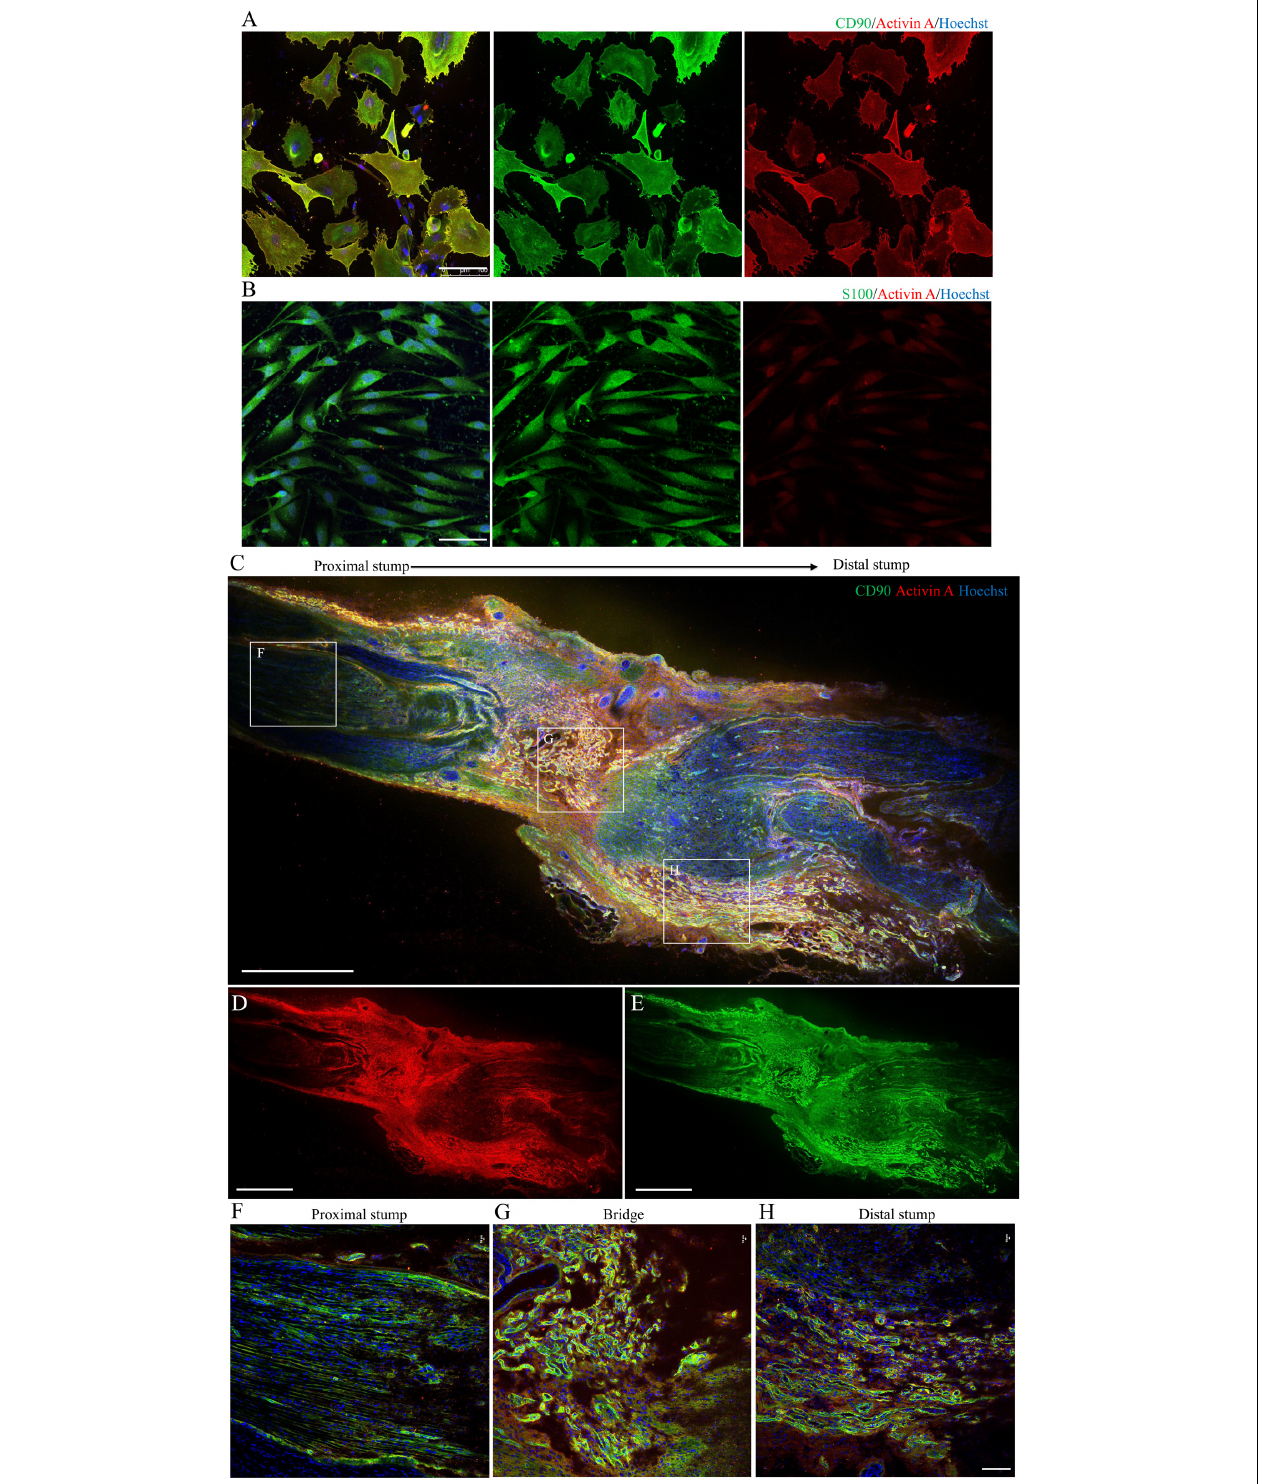
FIGURE 4 | Localization and expression of activin A in N-Fbs in vitro and rat sciatic nerve injury model in vivo . (A) Immunofluorescence for activin A and fibroblast marker CD90 in purified N-Fbs. Scale bar, 100 µ m. (B) Immunofluorescence for activin A and SC marker S100 in purified SCs. Scale bar, 100 µ m. Expression of activin A in rat sciatic nerve injury model in vivo . (C–E) Immunofluorescence images of activin A (D) and CD90 (E) in sciatic nerve, proximal to distal. Scale bar, 1000 µ m. (F–H) Magnified images of the regions demarcated by white boxes in (C) . Scale bar, 100 µ m.